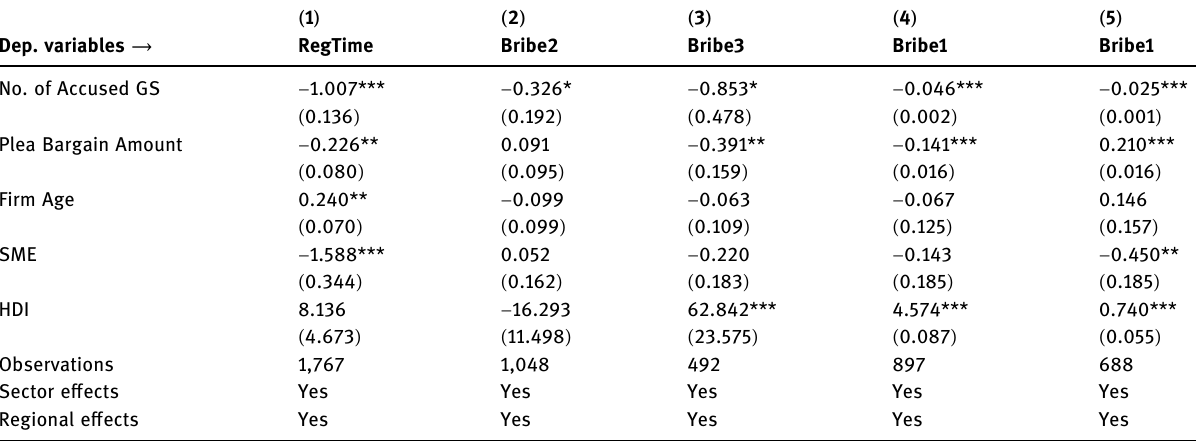
Table 5: Baseline results with alternative measures of fi rm - level corruption or with restricted